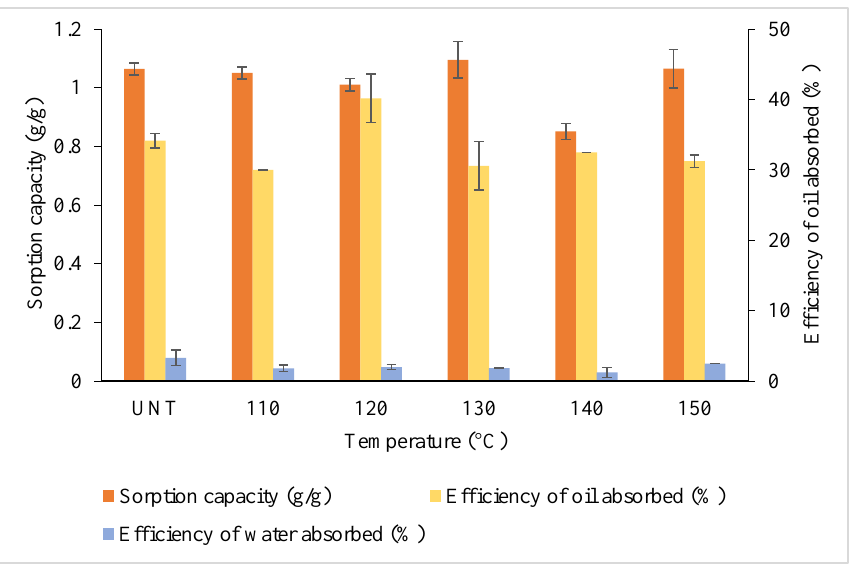
Figure 6. Effect of varying temperature (°C) on sorption capacity and oil/water absorption efficiency. Error bars indicates SD for the three replicates.